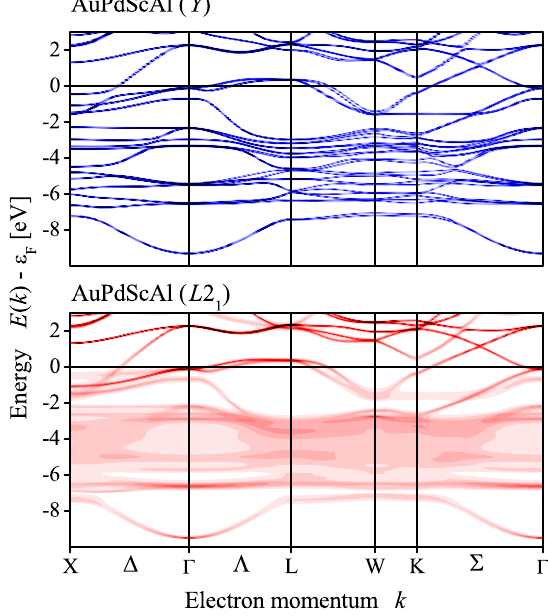
Figure 7. Bloch spectral function of ordered and disordered AuPdScAl.